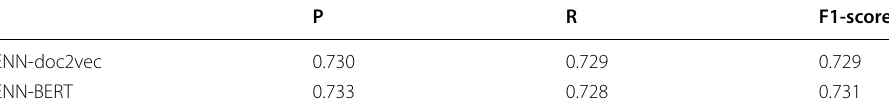
Table 5 Comparison of the Precision (P), Recall (R) and F1-scores of ENN-doc2vec and ENN- BERT